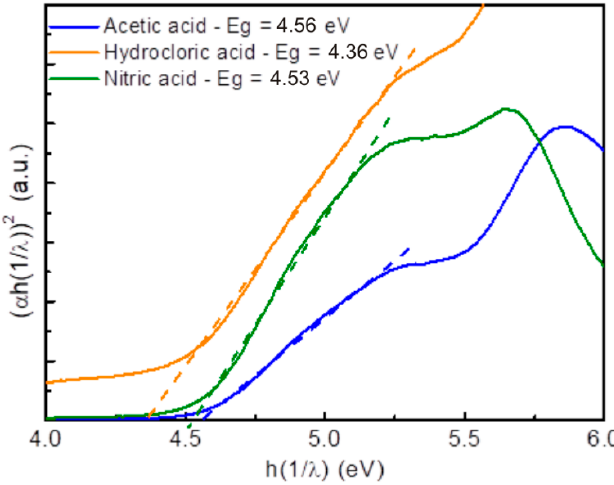
Figure 9. Tauc plot for the Yb/Eu doped Y 2 O 3 nanostructures produced with acetic, hydrochloric and nitric acids, respectively.